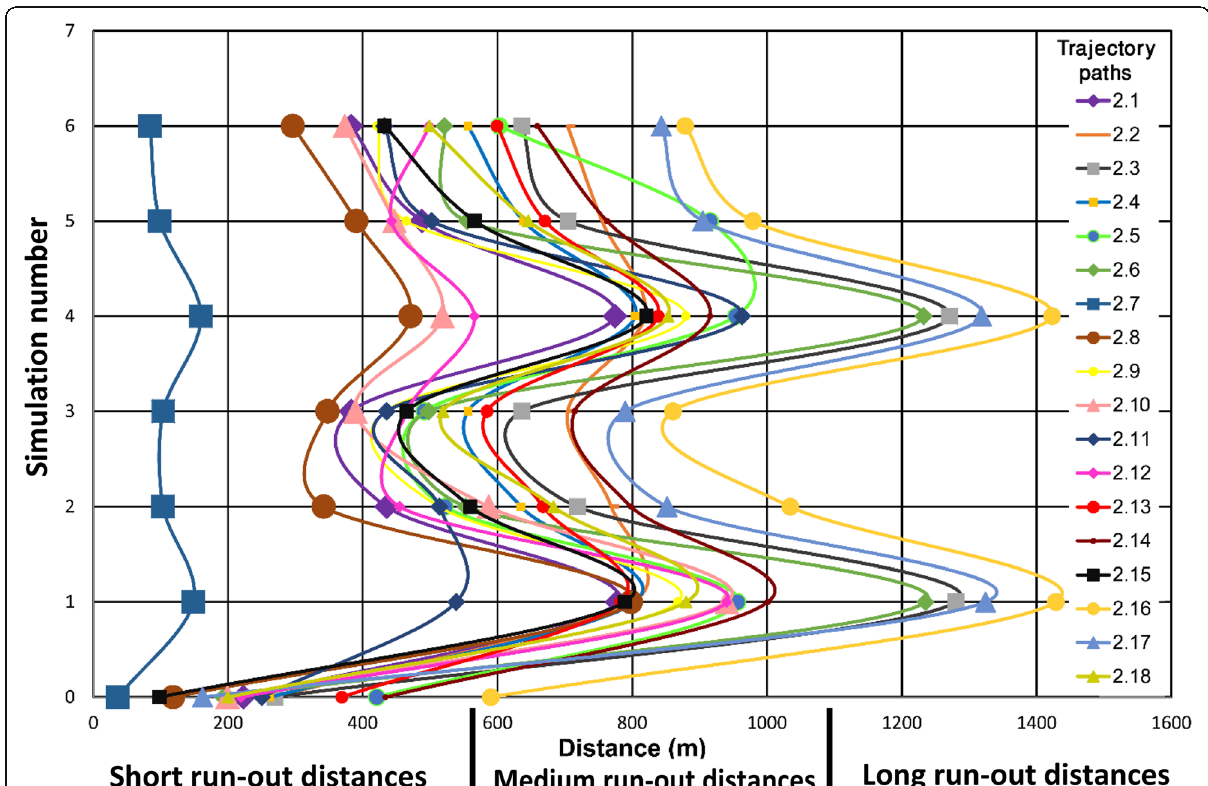
Fig. 10 Various simulation number (see Table 1 and it was decided as per different roughness values, i.e. 0 to 1) versus run-out distance in Plot